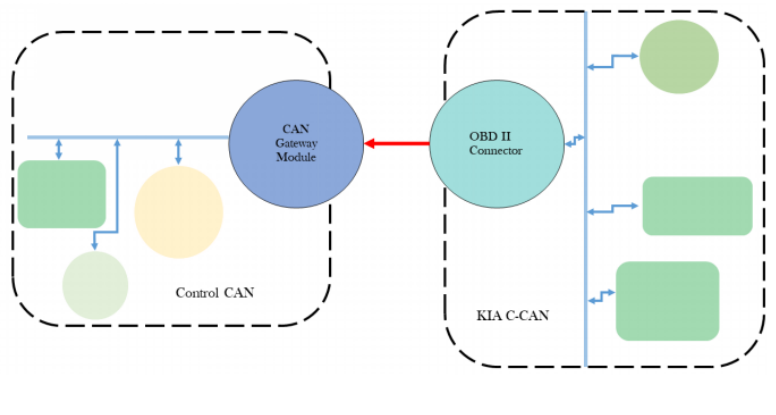
Figure 2. The communication lines between CAN Gateways Module and OBD Connector.